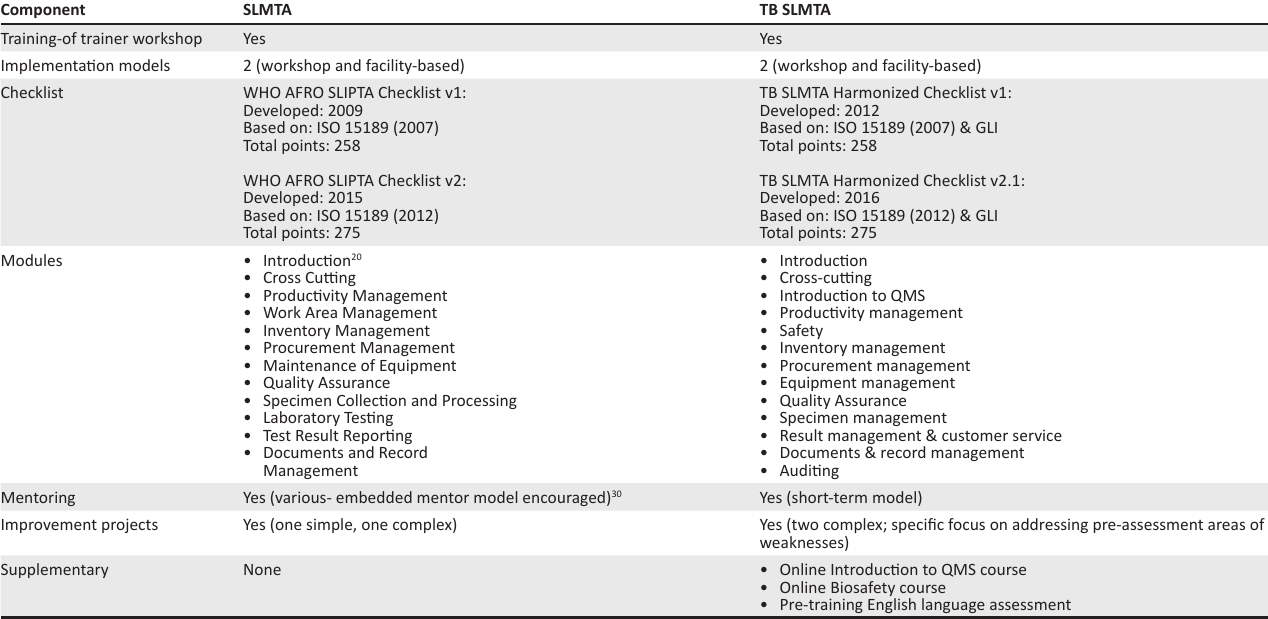
TABLE 1: Comparison of SLMTA and TB SLMTA programme components.